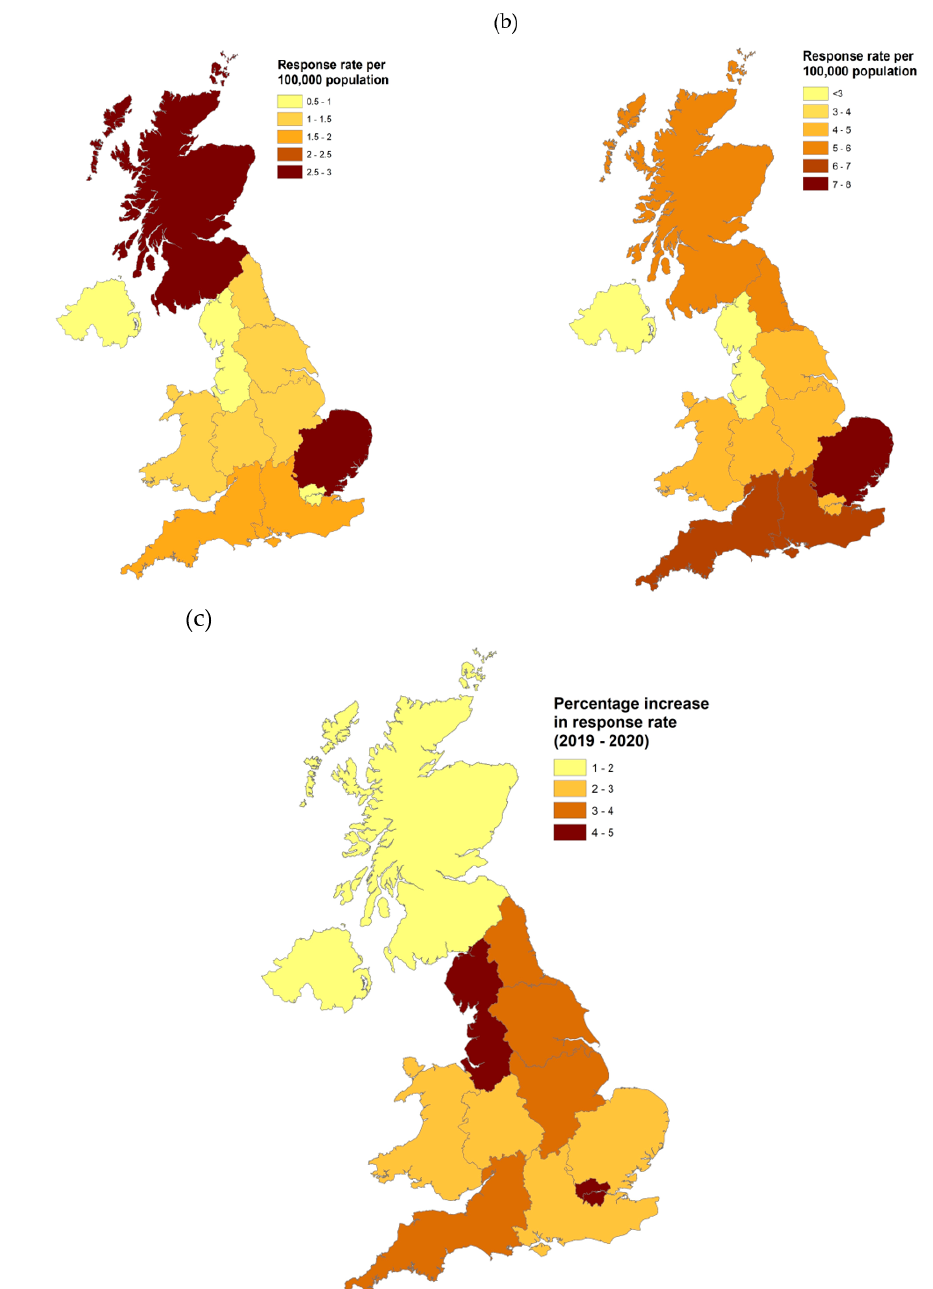
Figure 3. Choropleth maps of the UK describing the distribution of respondents who gave postcode data. ( a ) Respondents per 100,000 of UK population 2019 ( n = 946); ( b ) Respondents per 100,000 of UK population 2020 ( n = 3507); ( c ) percentage change of response rates between 2019 and